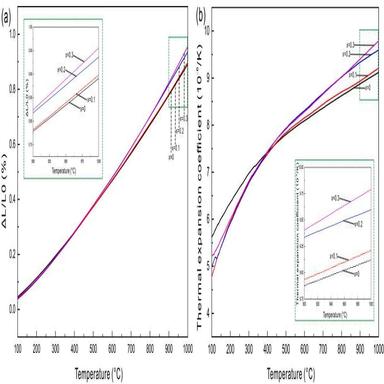
(a) Thermal expansion rates of (Y1-xLax)3Al5O12 (x = 0, 0.1, 0.2, 0.3) samples, (b) thermal expansion coefficients of (Y1-xLax)3Al5O12 (x = 0, 0.1, 0.2, 0.3) samples.